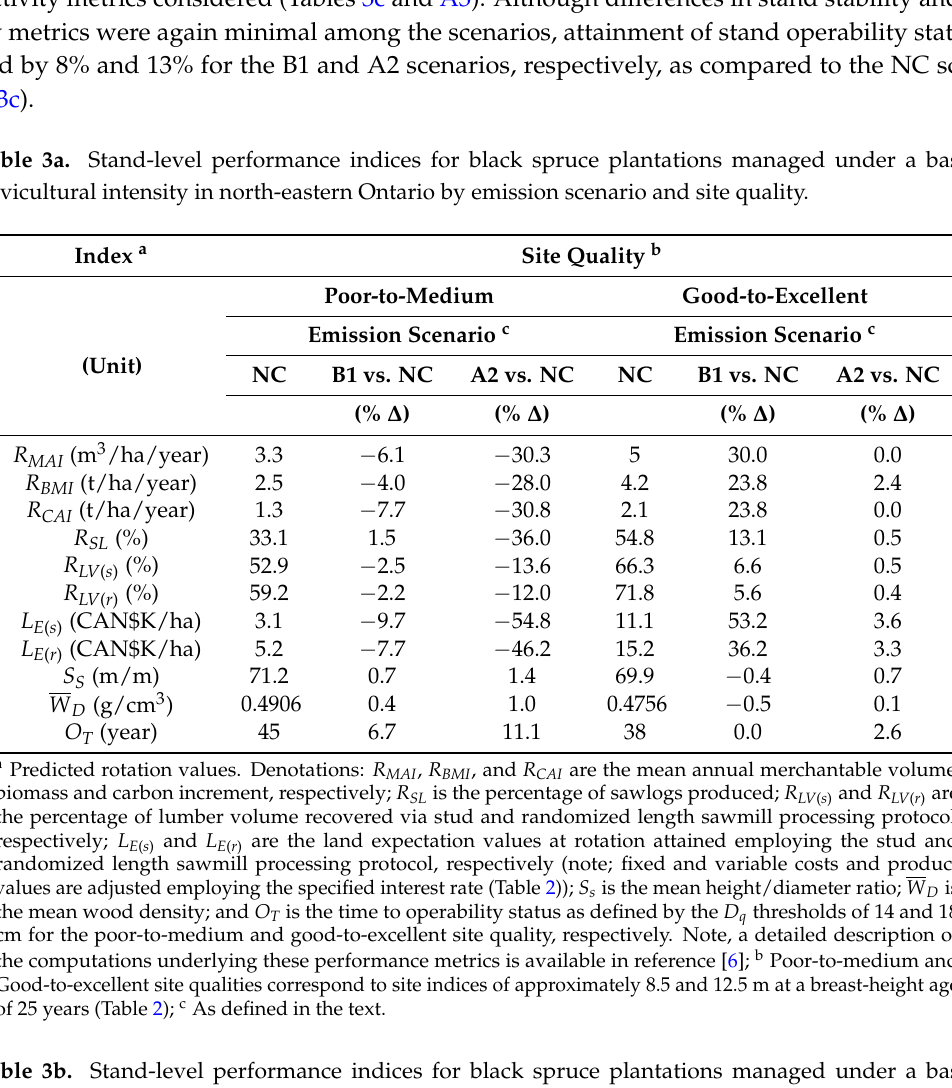
Table 3b. Stand-level performance indices for black spruce plantations managed under a basic silvicultural intensity in north-central Ontario by emission scenario and site quality.